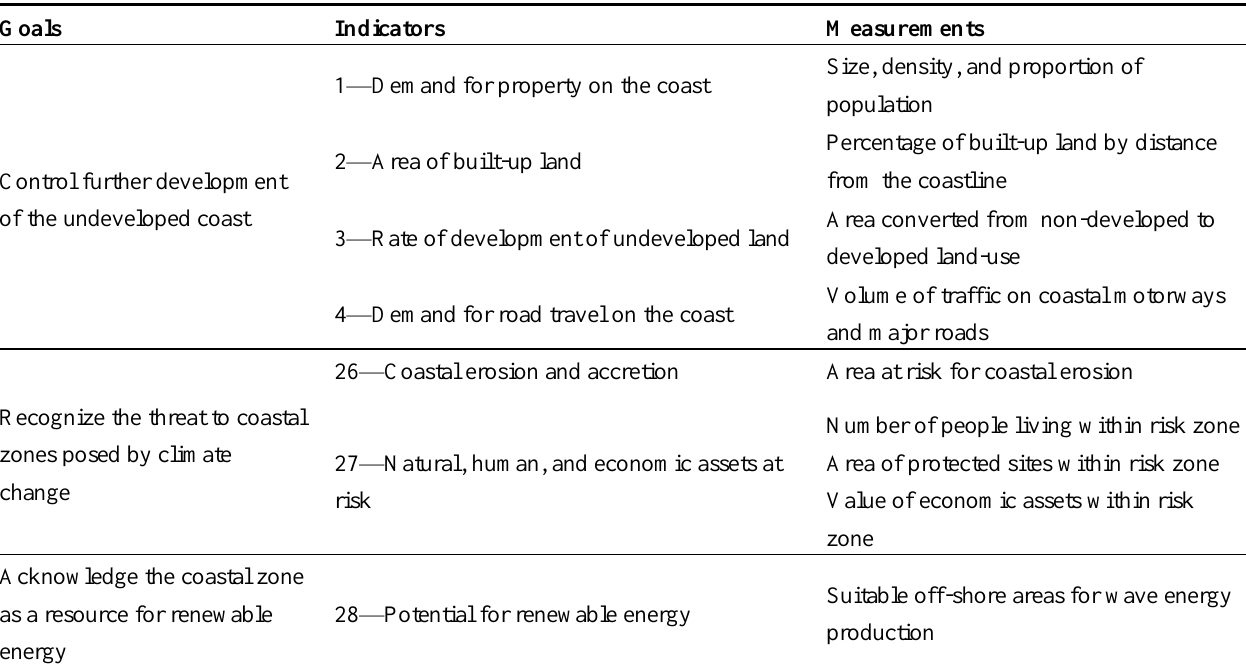
Table 1. Coastal indicators of sustainable development related to climate